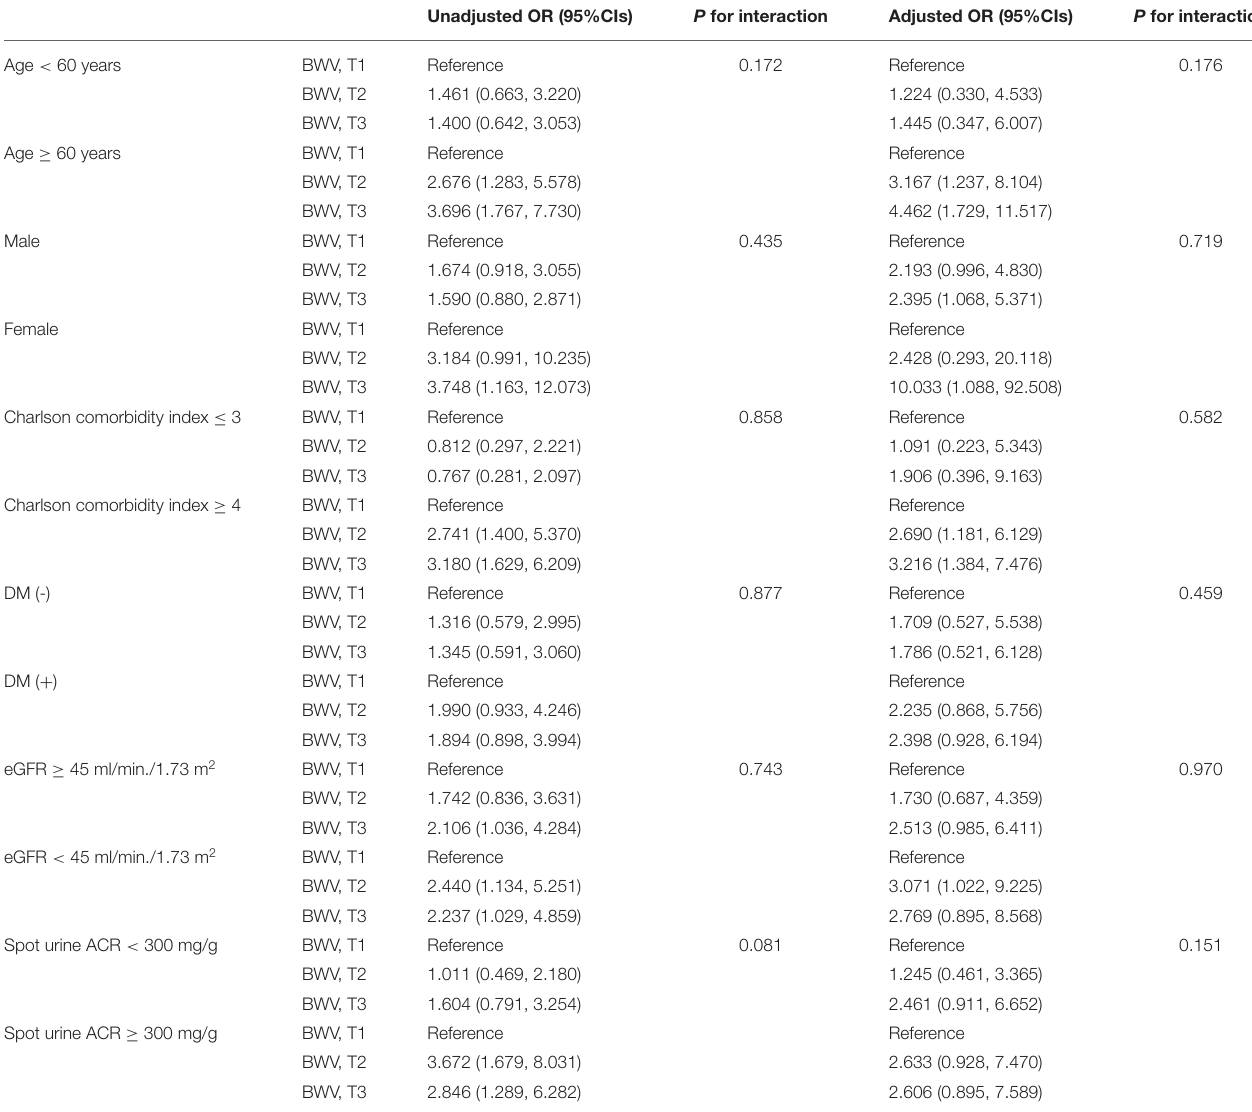
TABLE 4 | Binary logistic regression of BWV for rapid progression of CAC in various subgroups. Unadjusted OR (95%CIs) P for interaction Adjusted OR (95%CIs) P for